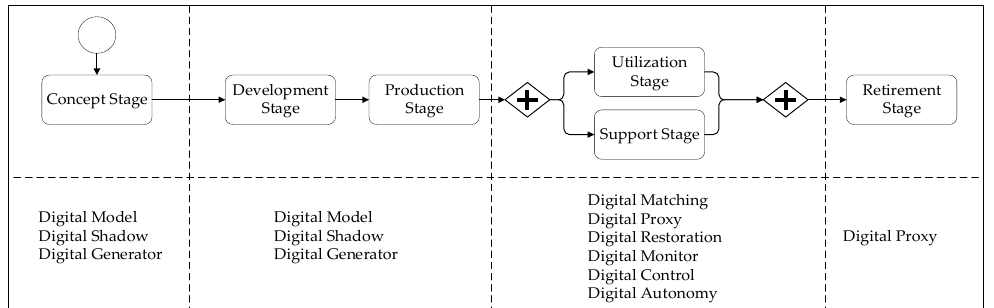
Figure 16. Identified patterns in the systems engineering life cycle stages.